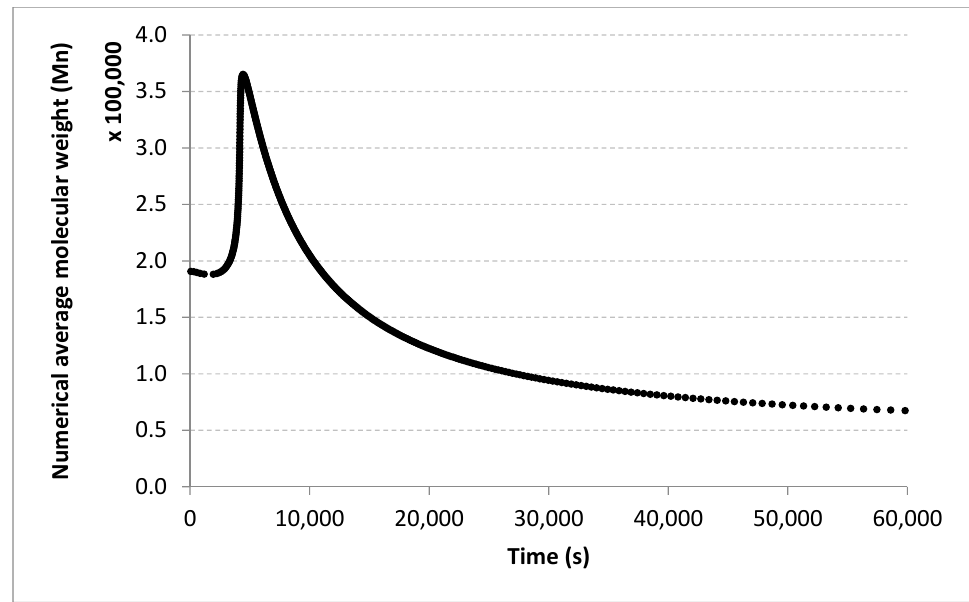
Figure 1. Adaptively sampled points (337) for the monomer conversion ( x ).